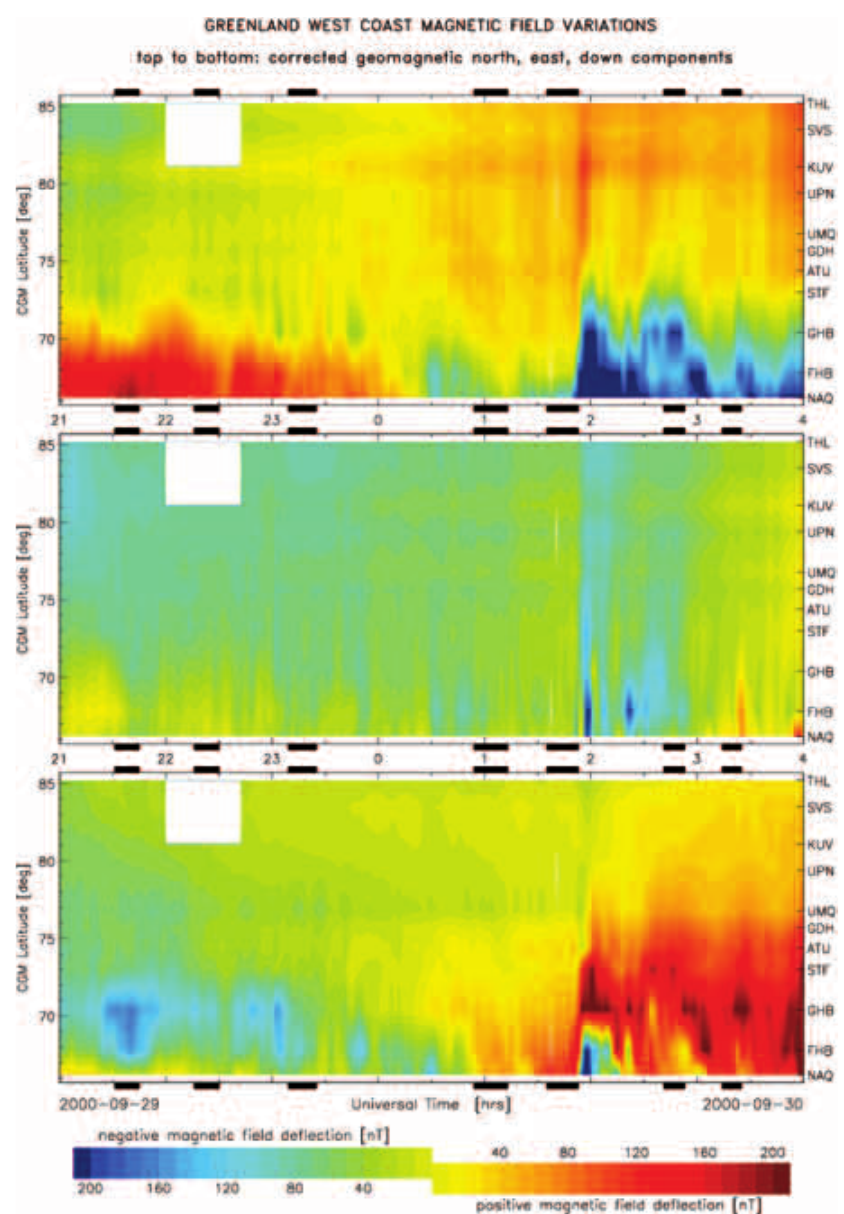
Fig. 4. Low-pass filtered magnetic field variations along the Greenland west coast (5 min cutoff), separated into geomagnetic north, east and vertical components. Since all stations approximately line up along the same corrected geomagnetic (CGM) meridian the magnetic field amplitude is plotted in a CGM latitude versus time diagram. The stations are listed along the right-hand ordinate at their respective CGM latitude. The magnetic field intensity is color- coded and white areas denote missing